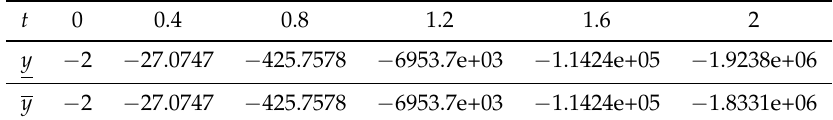
Table 6. Computation of lower and upper approximate solutions at multiple t for γ =